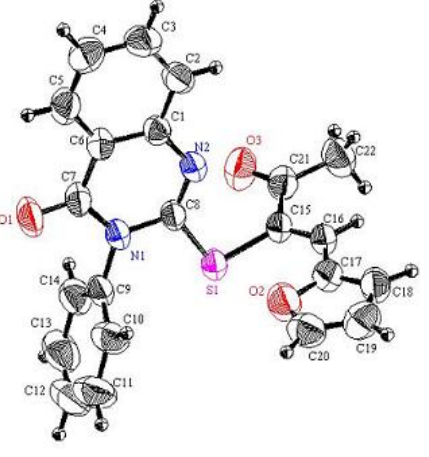
Figure 9. Perspective view and atom labeling of the X-ray structure of 10 .